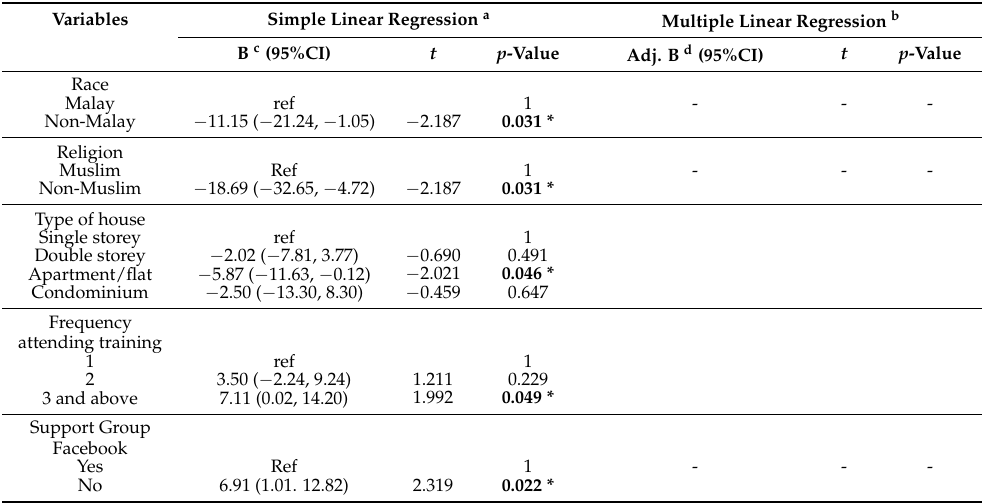
Table 5. Factors Associated with how problematic the child’s ASD difficulties (QoLA Part B) are among main caregivers (N =